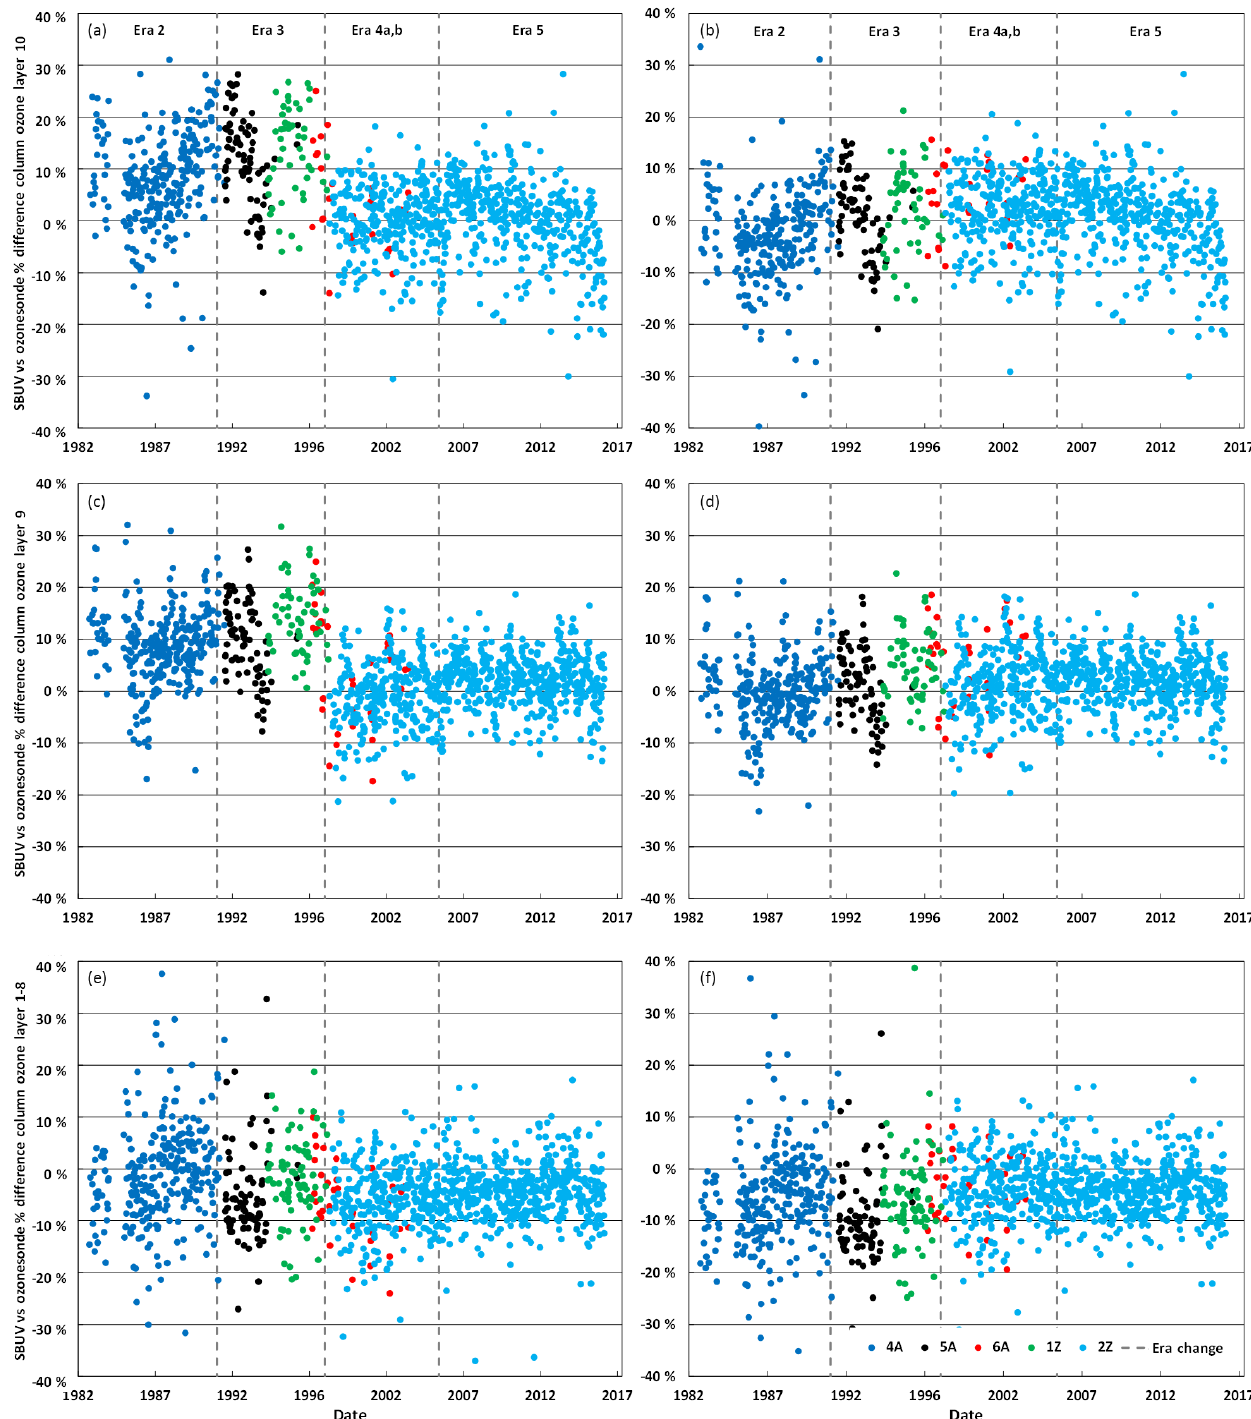
Figure 14. Percent difference in column ozone between the merged SBUV ozone data and the ozonesonde data at Hilo, HI. Panels (e) and (f) show Layers 1–8 (surface–25.45hPa), panels (c) and (d) show Layer 9 (25.45–16.06hPa), and panels (a) and (b) show Layer 10 (10.13–16.06hPa). Panels (a) , (c) , and (e) show before and panels (b) , (d) and (f) show after applying the ozone sensor